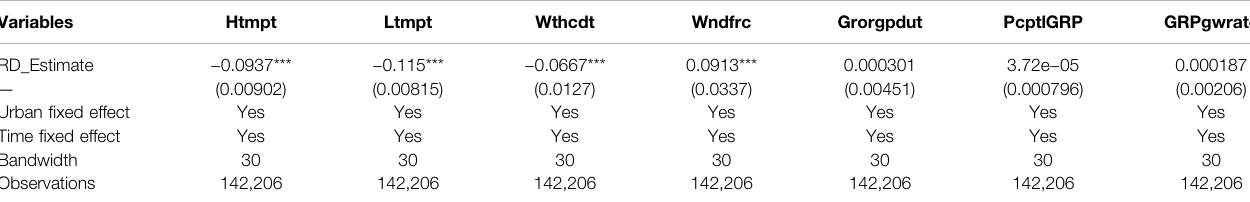
TABLE 5 | Results of the control variable continuity test.